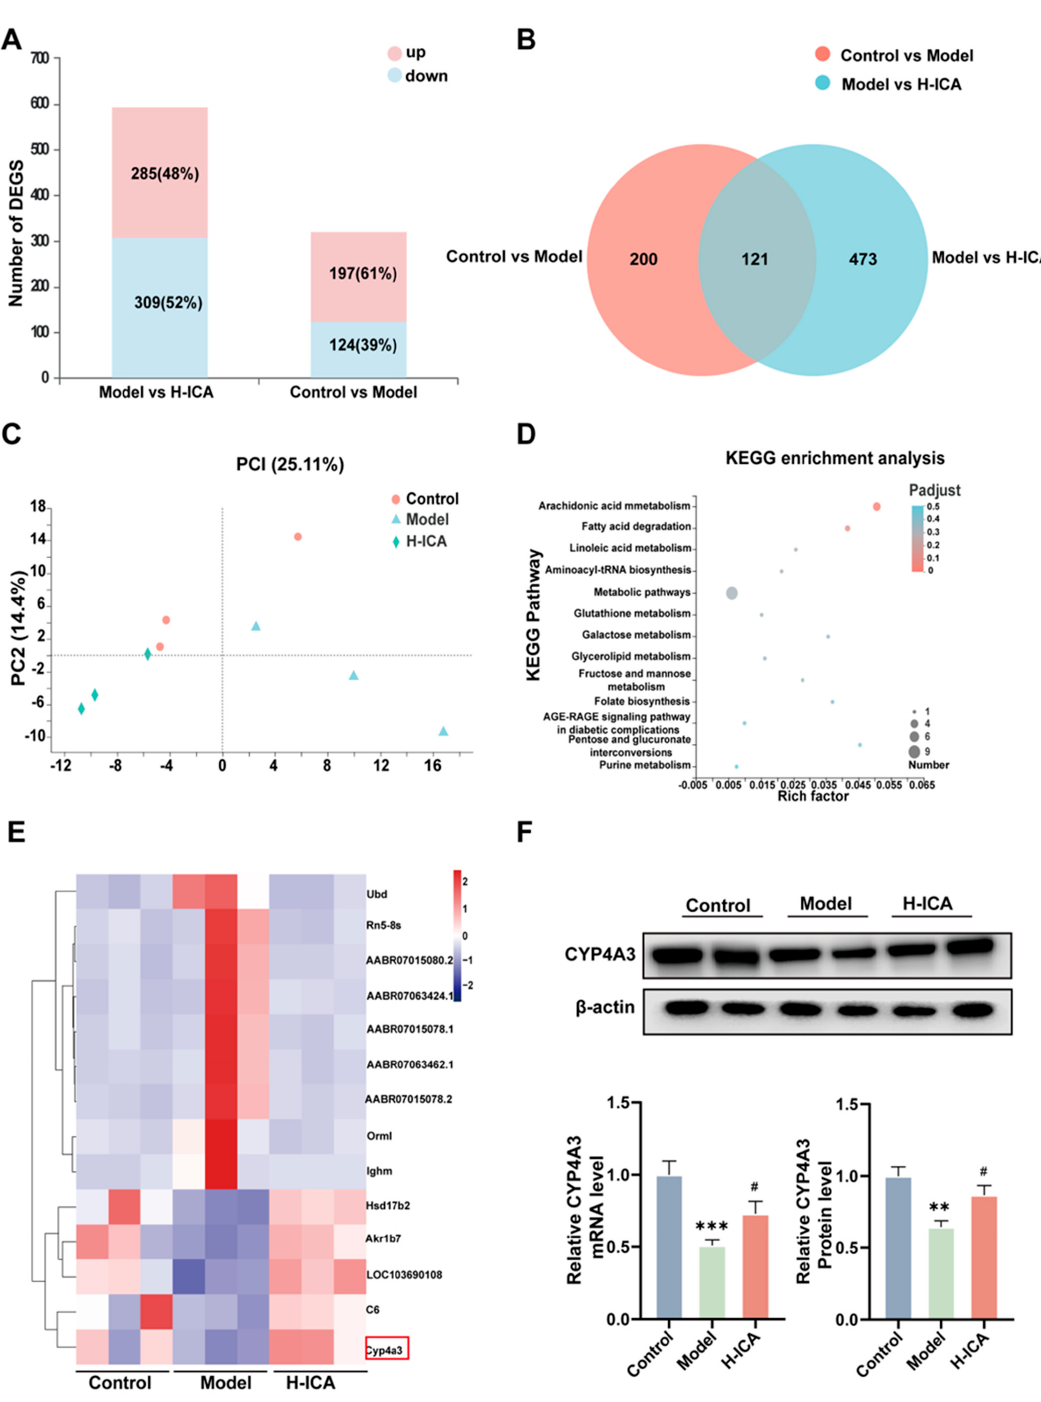
Figure 3. Effects of icariin on NAFLD in PCOS models as revealed by RNA-sequence analysis. RNA- sequence analysis of the molecular mechanism of icariin amelioration of NAFLD in PCOS. Superimposed graph of differently expressed genes ( A ). Wayne plot of differently expressed genes ( B ). PCA analysis based on different groups ( C ). Molecular mechanism of KEGG pathway analysis ( D ). Heat map analysis of differentially expressed genes with high expression ( E ). Trend validation of the screened differentially expressed genes CYP4A3 by qPCR (GAPDH as internal reference) and protein ( β -actin as internal reference) ( F ). n = 6, values are mean ± SEM; Control vs. Model, ** p < 0.01, *** p < 0.001; Model vs. drug group, # p <